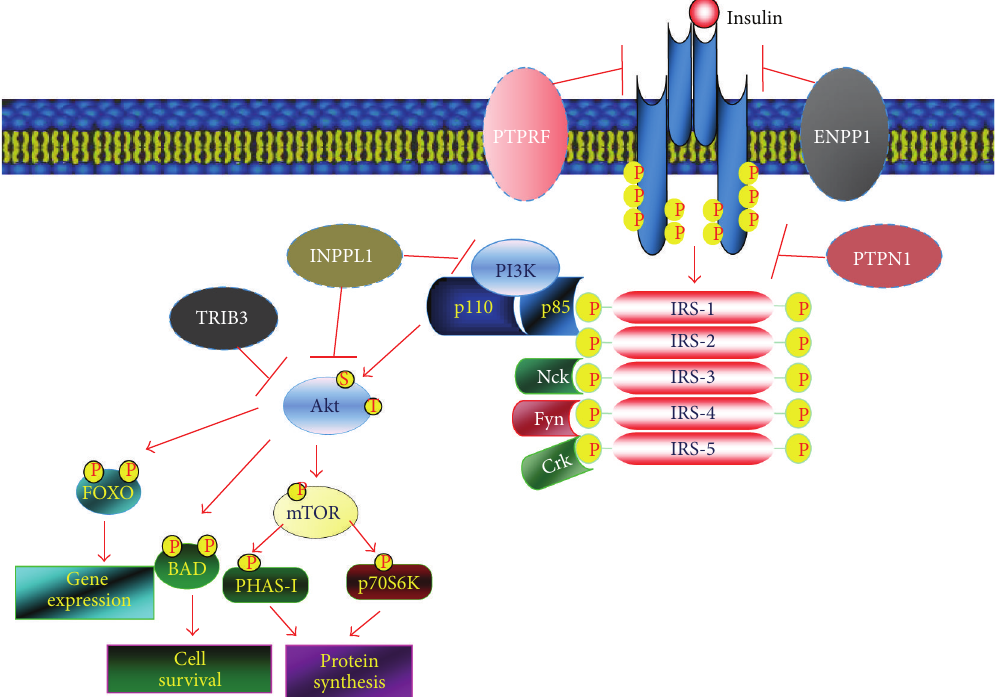
Figure 1: Schematic representation of the insulin-signaling pathway. Dashed light-blue line borders indicate insulin-signaling inhibitor proteins. PTPRF = protein tyrosine phosphatase receptor type F; ENPP1 = ectonucleotide pyrophosphatase/phosphodiesterase 1; PTPN1 = protein tyrosine phosphatase nonreceptor type 1; IRS = insulin receptor substrate; PI3K = phosphoinositides 3 kinase; nck = noncatalytic region of tyrosine kinase adaptor protein 1; INPPL1 = inositol polyphosphate phosphatase-like 1; TRIB3 = tribbles homolog 3; mTOR = mammalian target of rapamycin; Foxo = forkhead box protein O1; BAD = Bcl-2-associated death promoter; PHAS-I = phosphorylated heat- and acid-stable protein regulated by insulin; and p70S6K = p70-ribosomal S6